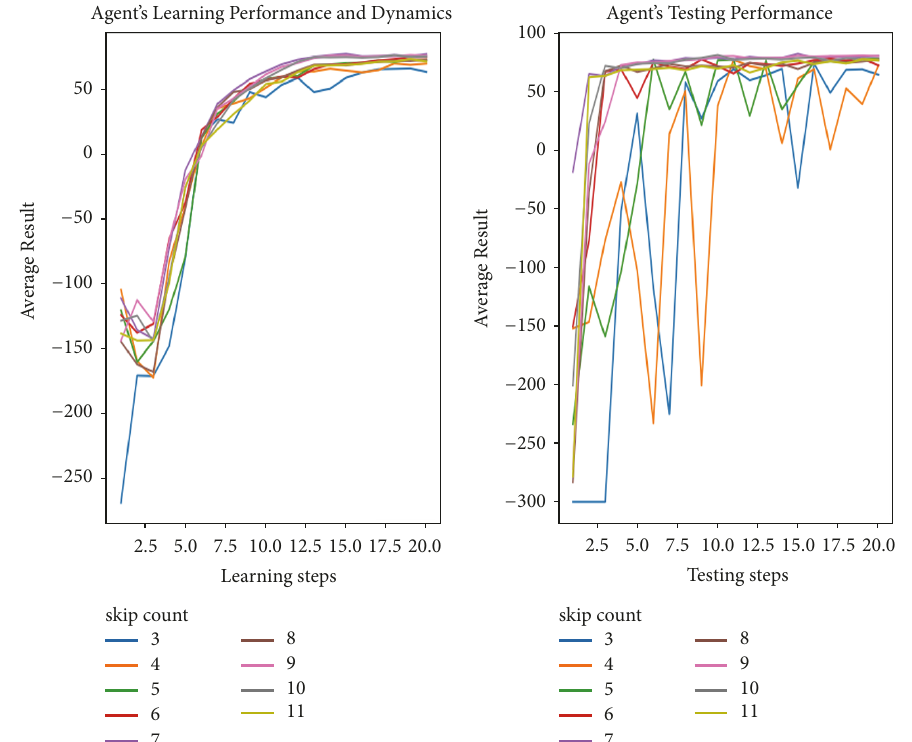
Figure 5: Showing the agent learning and testing performance for 3-11 optimal skip counts only.